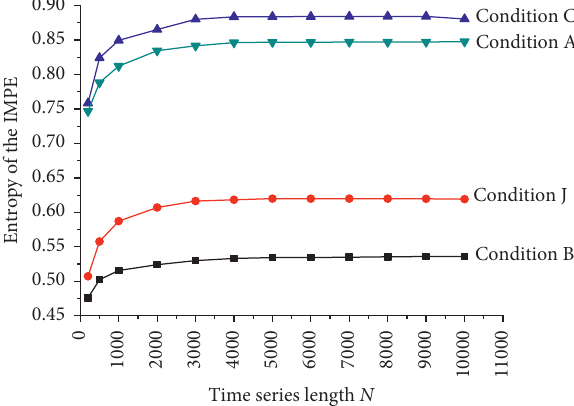
Figure 8: Entropy value variation diagram of pipeline under different working